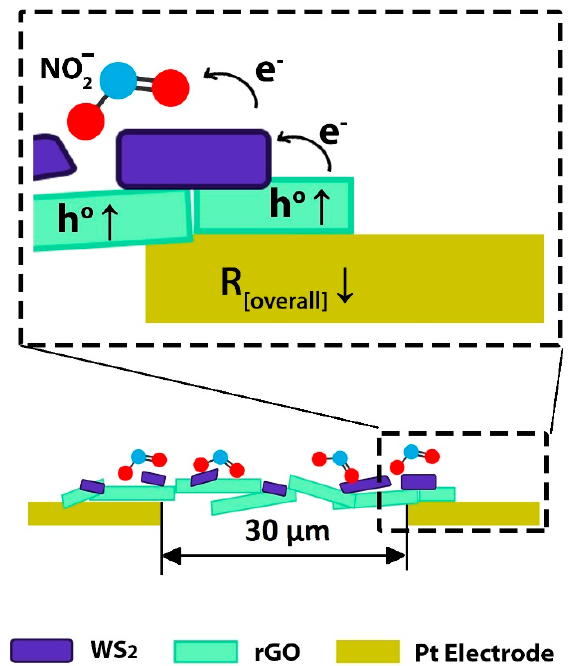
Figure 10. Schematic illustration of the proposed sensing mechanism of WS 2 -decorated rGO hybrid during NO 2 exposure.